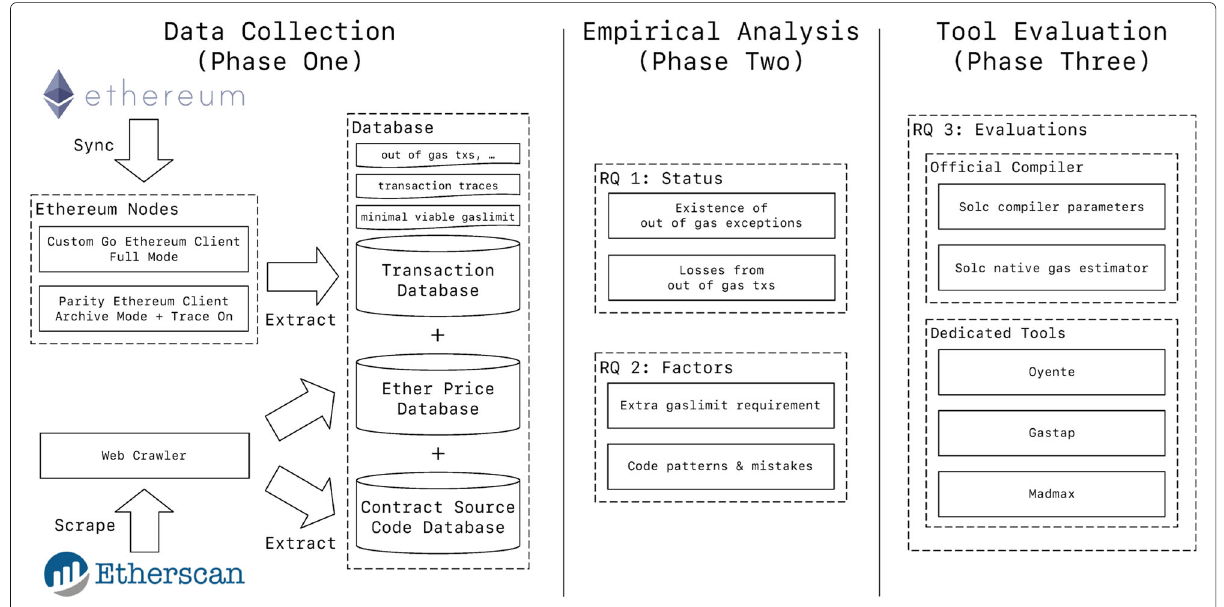
Fig. 3 An overview of our methodology